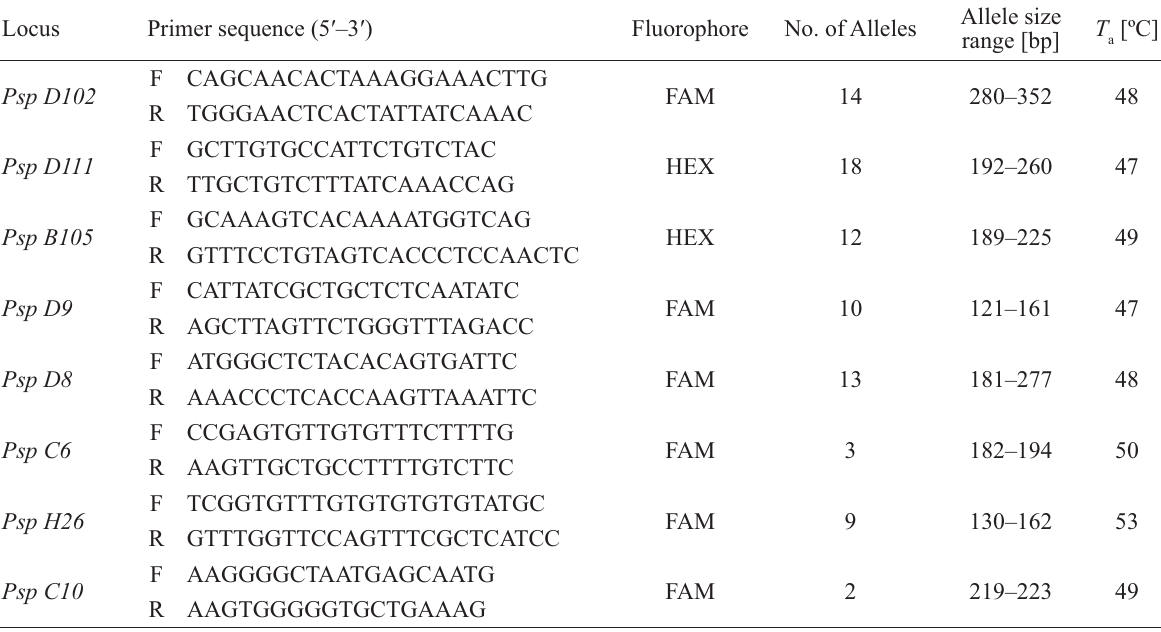
Characterization of eight disomic microsatellite loci for the paddlefish, Polyodon